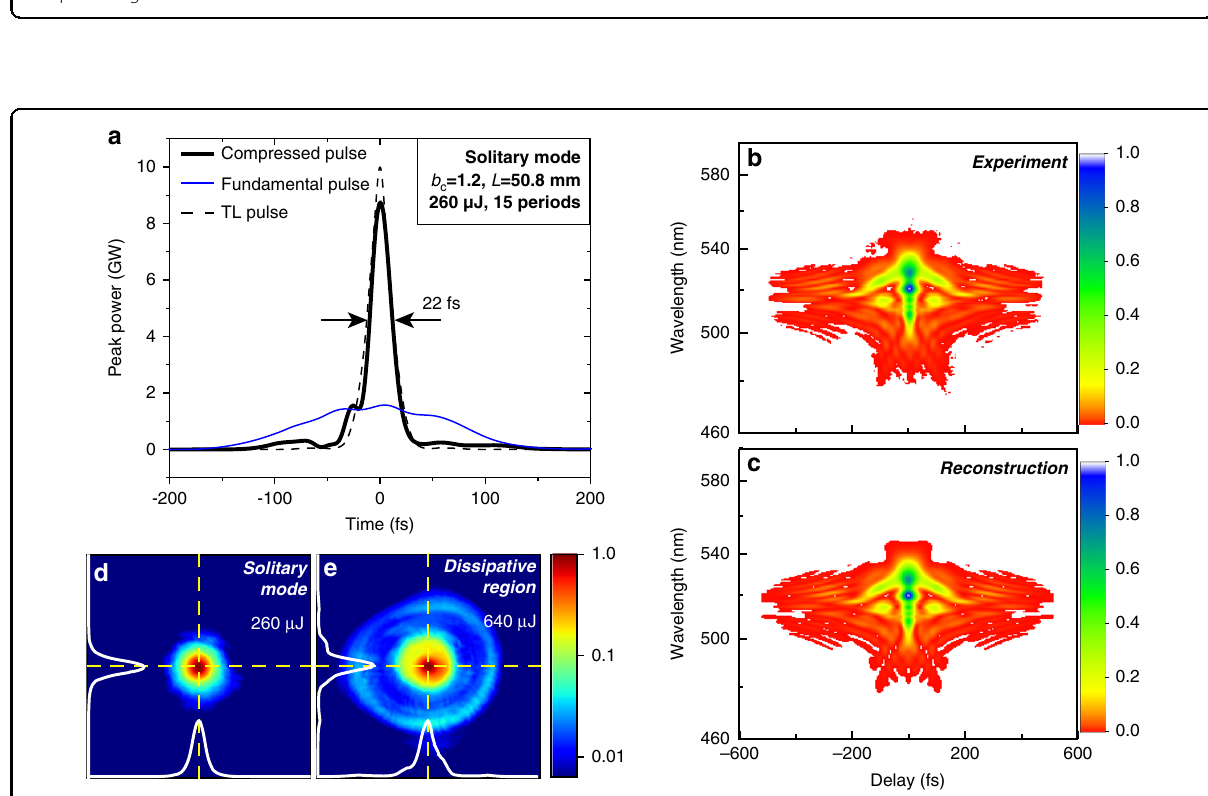
Fig. 2 Variations of the spatial, spectral and temporal pro fi les under different conditions. a The spectral bandwidth and normalized beam radius as a function of the nonlinear phase and pulse energy for the PLKM resonator with L = 50.8 mm and 15 layers. The dashed lines are the results of the NLSE simulations. b , c Far- fi eld spectral and temporal pro fi les in different stability regions. d Time-frequency analysis (Wigner plots) of the output pulses under the solitary mode. f c is the central frequency. The contours label the 1/e 2 intensity. e Same as ( d ). but for the output pulses in the dissipative region